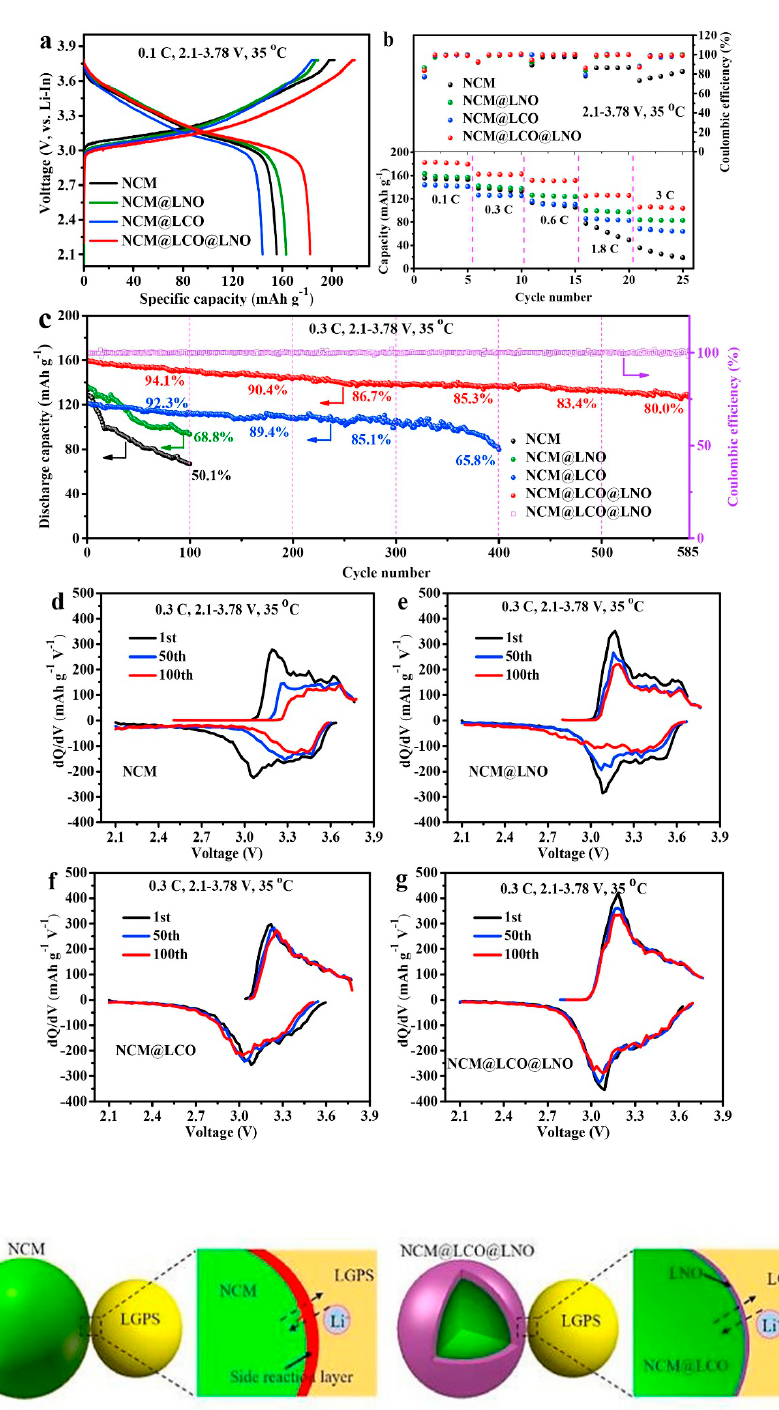
Figure 21. Electrochemical performances of NMC-811, NMC@LNO, NMC@LCO, and NMC@LCO@LNO cathodes for all-solid-state Li-ion batteries (ASSLB) with Li 9.54 Si 1.74 P 1.44 S 11.7 Cl 0.3 as the solid electrolyte at 35 ◦ C. Here NMC811, LCO, and LNO denote LiNi 0.8 Co 0.1 Mn 0.1 O 2 , Li[(Ni 0.8 Co 0.1 Mn 0.1 ) 0.9 Co 0.1 ]O 2 , and LiNbO 3 , respectively. ( a ) Initial charge–discharge, ( b ) rate performance, and ( c ) cycle performance curves after the rate performance test (1C = 200 mA g − 1 ). ( d )–( g ) d Q / d V curves of the four ASSLB cathodes at the 1st, 50th, and 100th cycle at 35 ◦ C. ( h ) Schematic diagrams of the mitigation of the side reaction by NBO coating. Reproduced with permission from [298]. Copyright 2020 Elsevier.